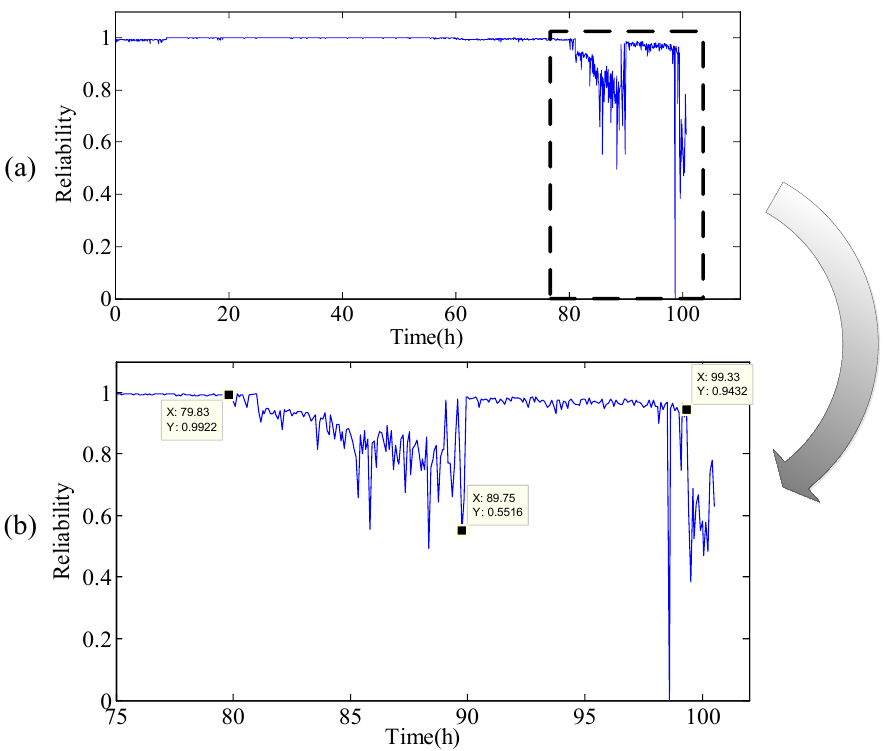
Figure 14. ( a ) Few-shot reliability estimation result via statistical indexes; ( b ) local enlargement.